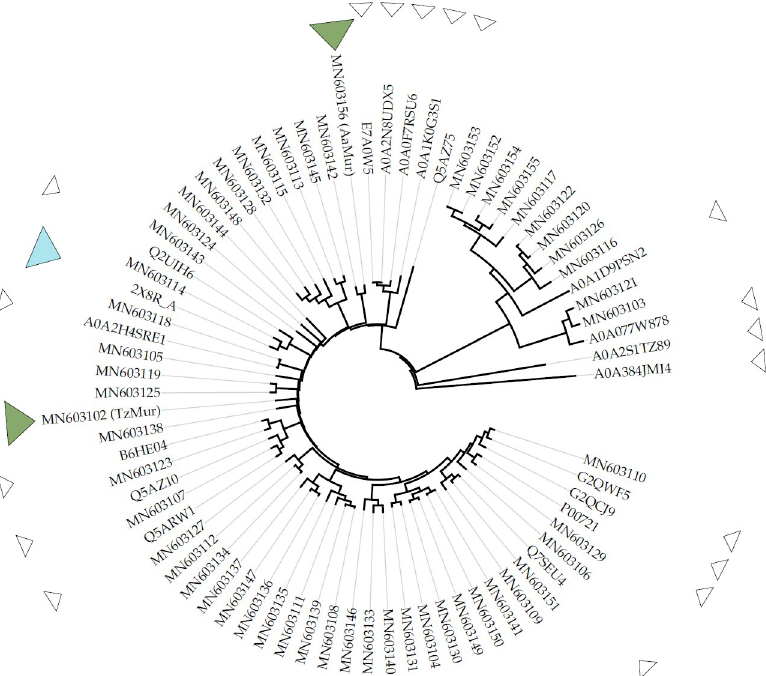
Fig 1. Evolutionary tree of fungal GH25 muramidases. The set of 55 GH25 sequences included in the screening process (GenBank accession id:MN603101 to MN603156) and public fungal GH25 sequences in the CAZy-database [3] (https://www.cazypedia.org/index.php/Glycoside_Hydrolase_Family_25). The open triangles indicate a public sequence, the light-blue triangle is a fungal GH25 structure from the PDB while the green triangles indicate the structures reported here. The organism names of MN603101-MN603156 are given in Table 3.